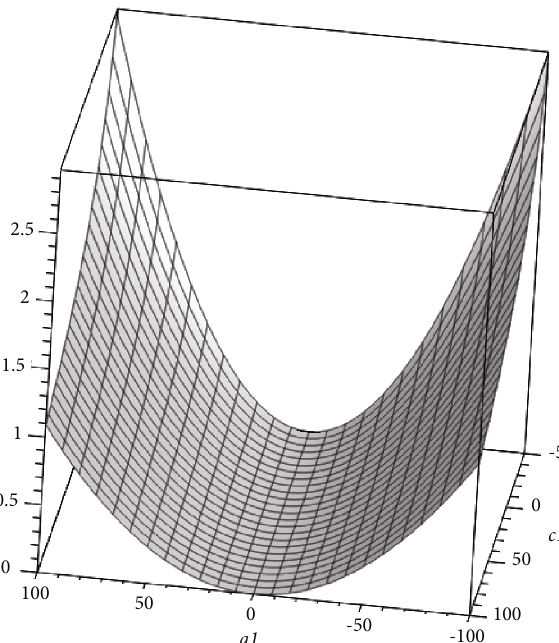
Figure 5: The graph of the data ( a and − 50 ≤ c